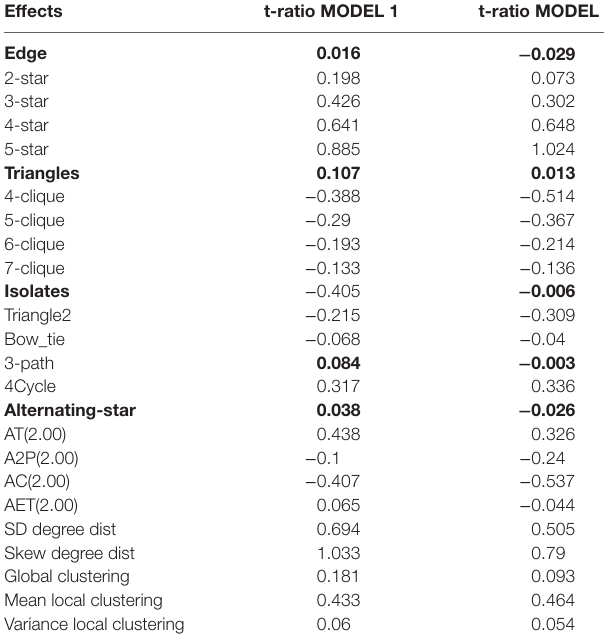
TaBle 7 | Goodness-of-fit t-ratio results for models 1 and 2 presented in Table 6 above.